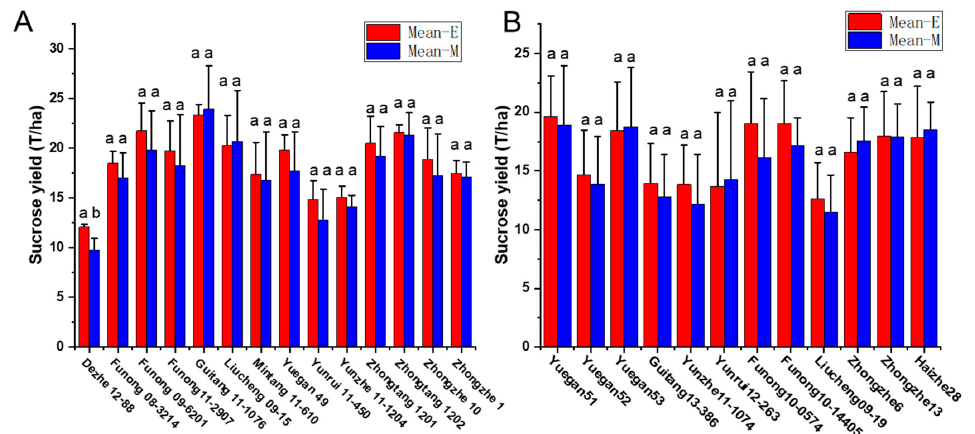
Figure 5. Comparison of the measured and estimated mean sucrose yield of 26 sugarcane cultivars in three crop seasons, including the plant cane, the first ratoon cane, and the second ratoon cane. Mean-E and Mean-M indicate the estimated and measured mean sucrose yield. The sucrose yield of 14 cultivars were measured from 2018 to 2020 in ( A ), and the sucrose yield of the other 12 cultivars were measured from 2019 to 2021 in ( B ). “ab” represent significant differences at p < 0.05, and “aa” represent no significant differences at p < 0.05.